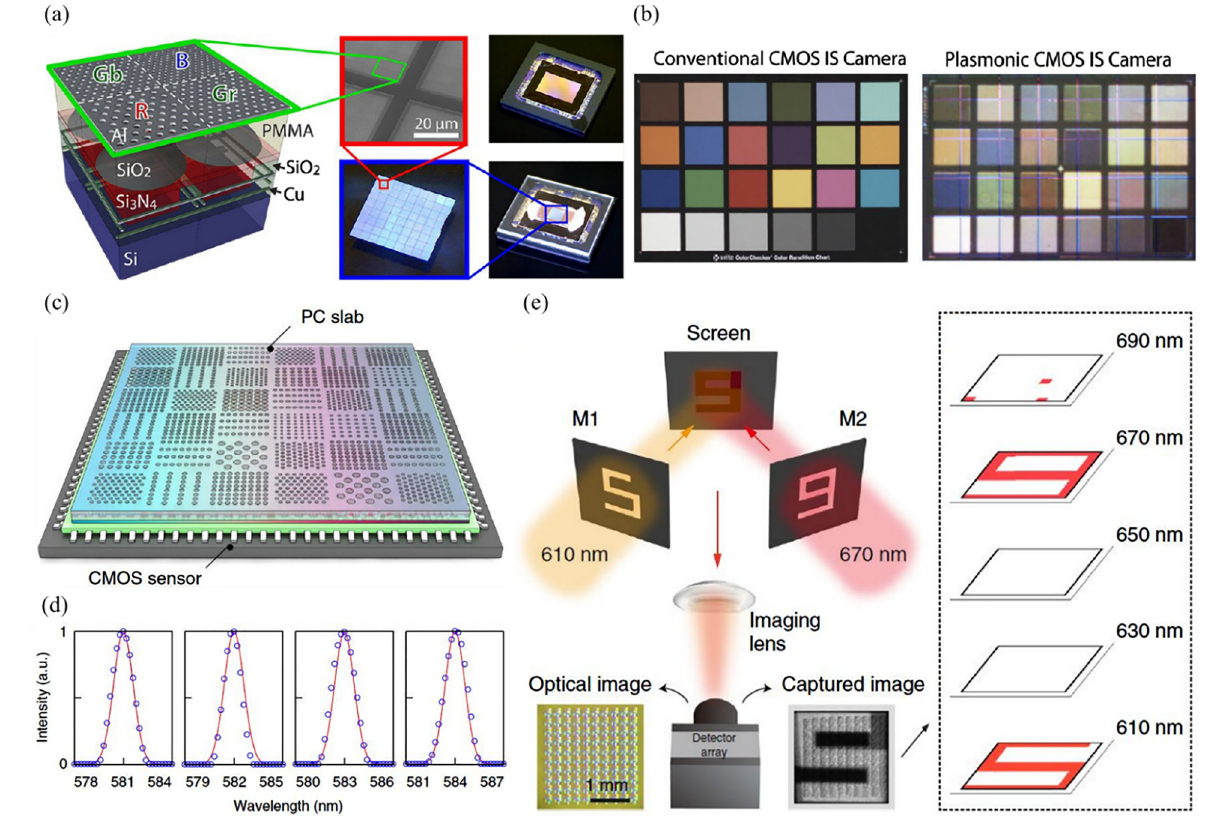
Figure 10: Metallic and dielectric nanophotonics spectral filters integrated with CMOS sensor for spectral imaging.